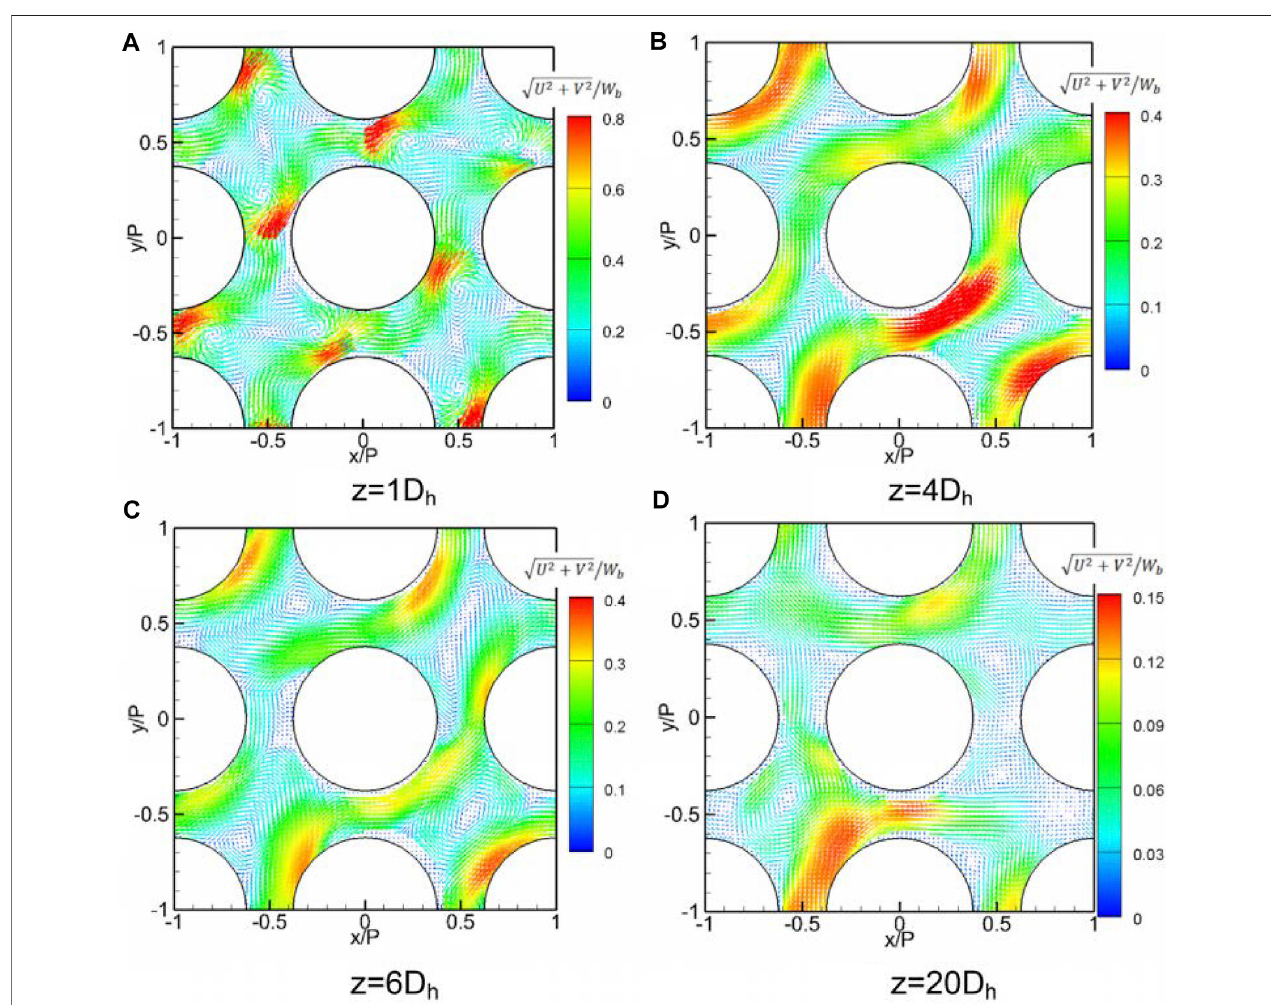
FIGURE 11 | Cross- fl ow structure from z (cid:2) 1D h to z (cid:2) 20D h (Xiong et al., 2020).